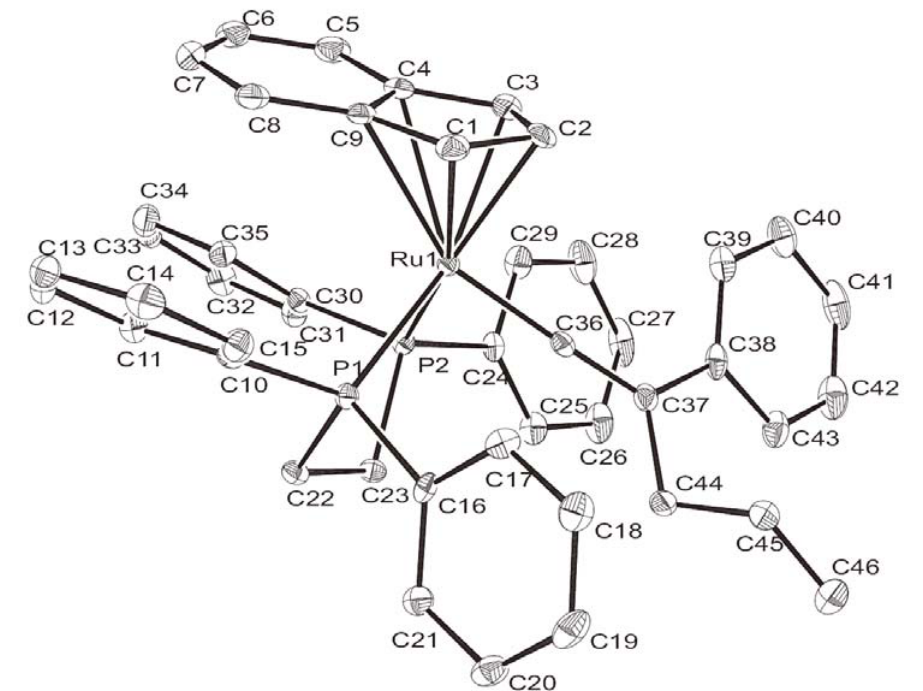
Figure 1. ORTEP plot of complex 2a drawn at the 30% probability